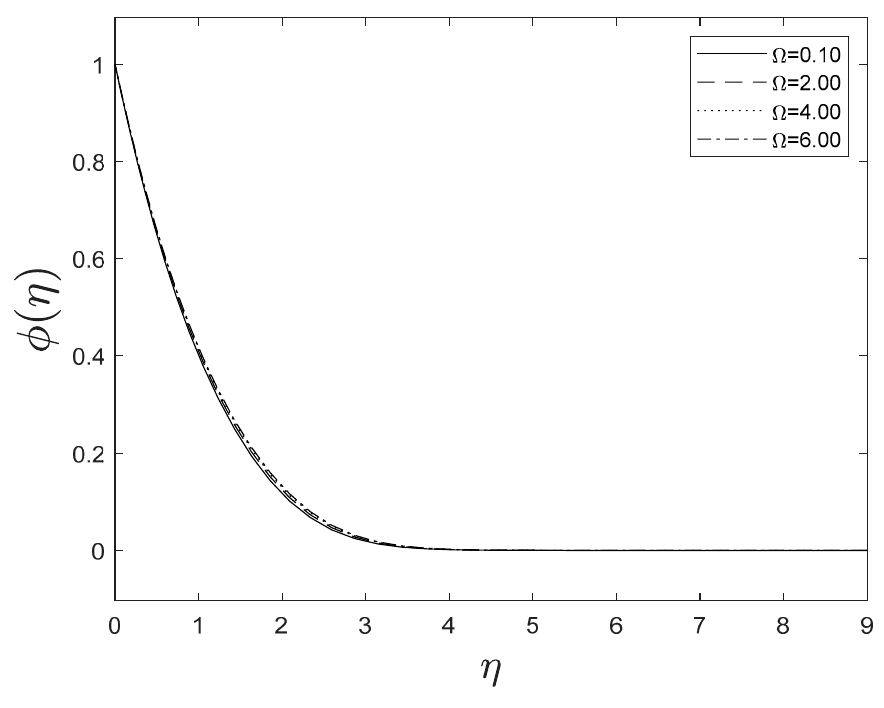
Ω φη on ( ) . Figure 22. Effect of different values of Ω on φ ( η )